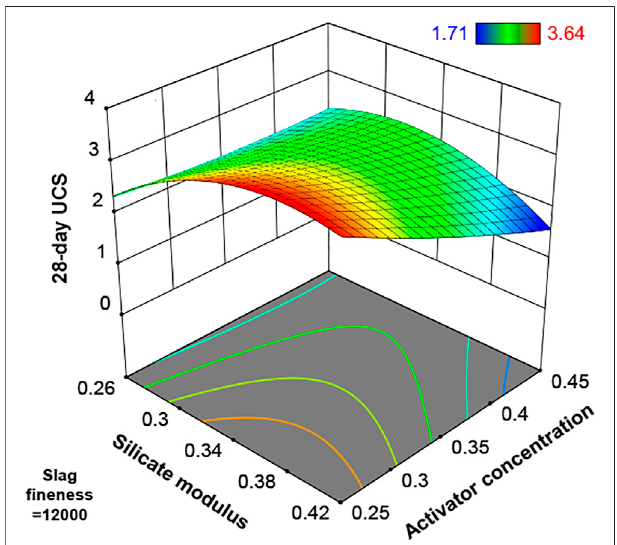
FIGURE9| Response-surfaceofthein fl uenceofactivatorconcentration and its interaction with slag fi neness for a silicate modulus of 0.34.